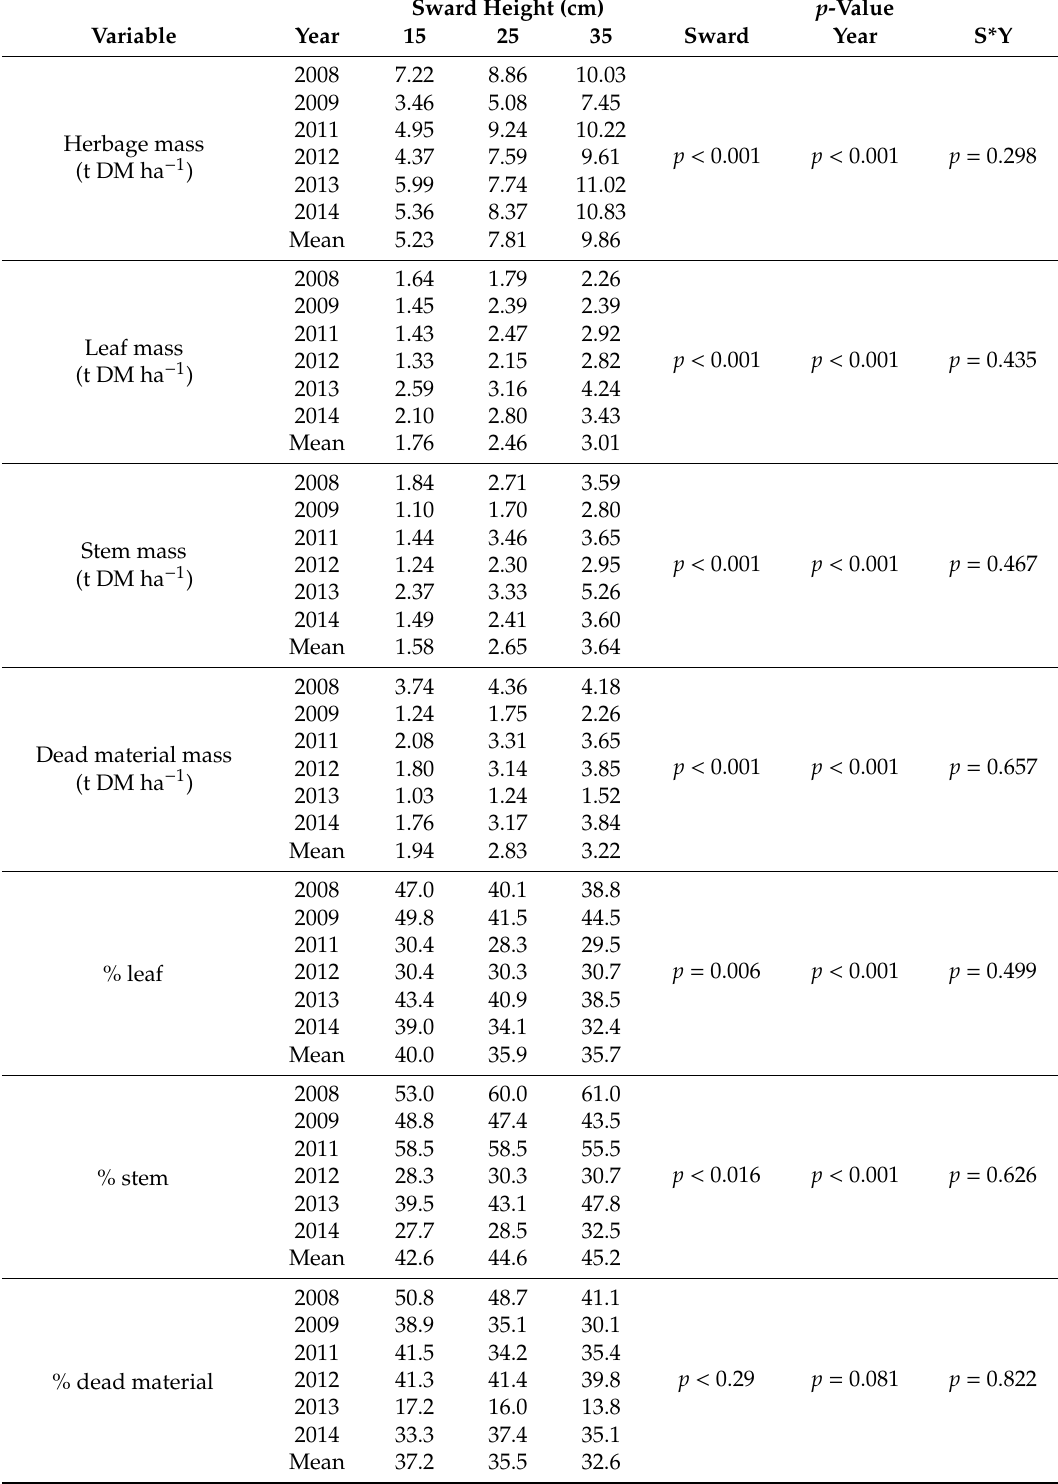
Table 3. Herbage mass and structural characteristics of Marandu grass managed at different sward heights 1 . Sward Height